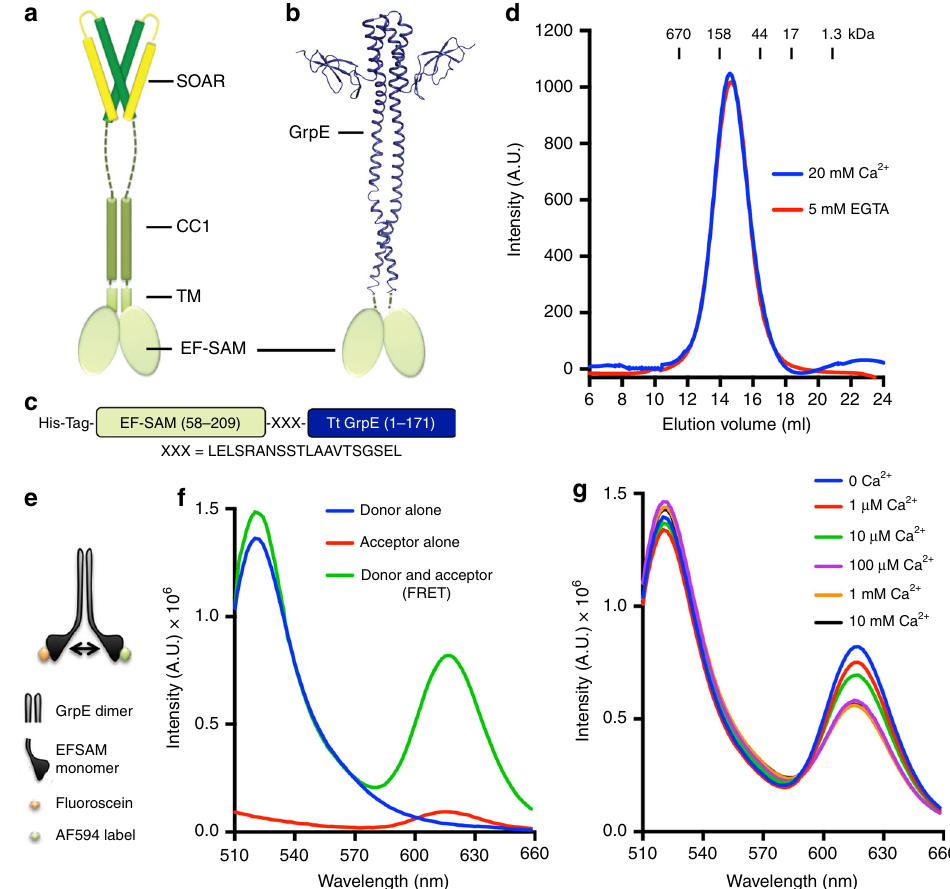
Fig. 1 EFSAM-GrpE design and Ca 2 + responsiveness. a Cartoon of activated STIM1 (58-473) as inferred from the literature 45 . Domain organization is marked. Residues 24 – 57 and 473 – 685 are not depicted. b Cartoon of the expected EFSAM-GrpE structure used in the current study, showing structural similarity to the extended activated STIM1. Green ovals represent EFSAM (58-209) and blue cartoon denotes Thermus thermophilus GrpE. GrpE is not structurally related to STIM1 except for the presence of extended α -helices that form a coiled coil. The coiled coil is constitutive in GrpE, unlike in STIM1. c Schematic of the EFSAM-GrpE construct design. d Size exclusion chromatography of the Ca 2 + -bound (20 mM Ca 2 + ; blue line) and Ca 2 + -free (5 mM EGTA; red line) forms of EFSAM-GrpE. e Schematic of chemical labelling of EFSAM-GrpE, depicting the case where individual monomers are labelled with fl uorescein and AF594. Other possible combinations in the random labelling approach used here are not illustrated. f Fluorescence emission spectra ( λ 420 nm) of single-cysteine EFSAM-GrpE labelled with fl uorescein (Donor alone), AF594 (Acceptor alone) or with both dyes (Donor and Acceptor). All measurements were made in Ca 2 + -free buffer. g Fluorescence spectral scans ( λ ex = 420 nm) of double-labelled EFSAM-GrpE with varying amounts of Ca 2